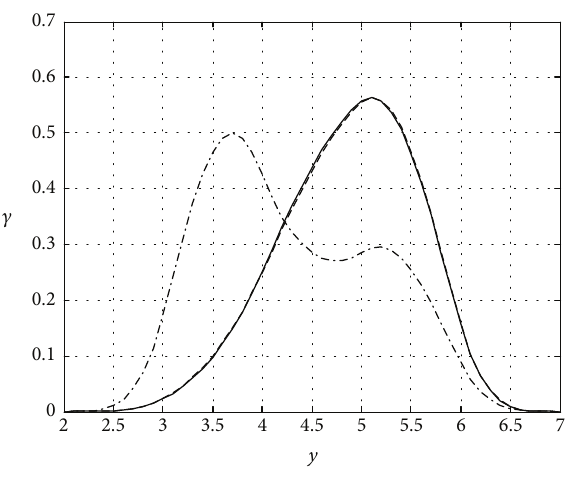
Figure 2: Fault and its estimation.